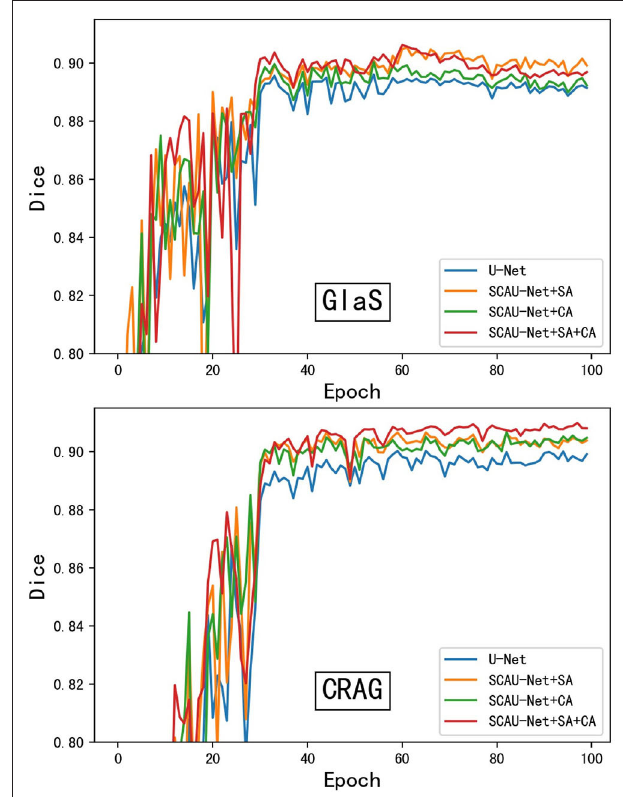
FIGURE 4 | The training process of different model. Figure shows dice curve of the U-Net and SCAU-Net with different settings (CA, SA, CA+SA) on validation sets. CA, channel attention module; SA, spatial attention